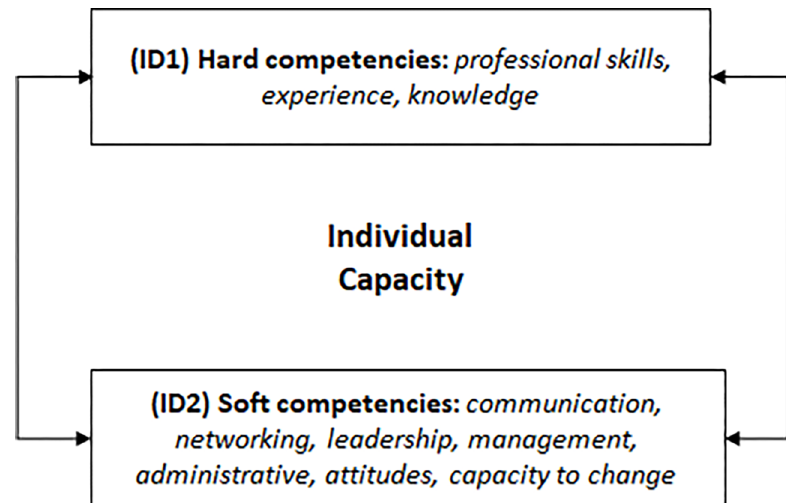
Figure 1. Individual